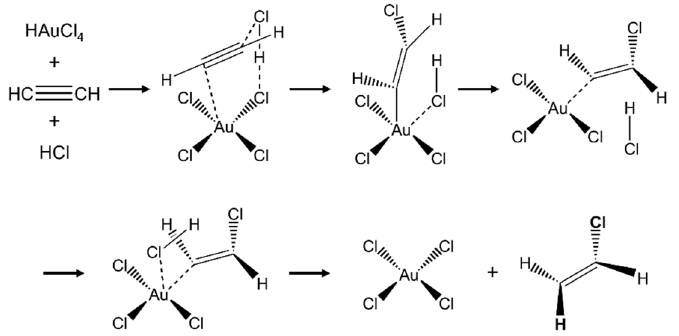
Figure 4. Acetylene hydrochlorination model of Au 3+ catalyst [5].